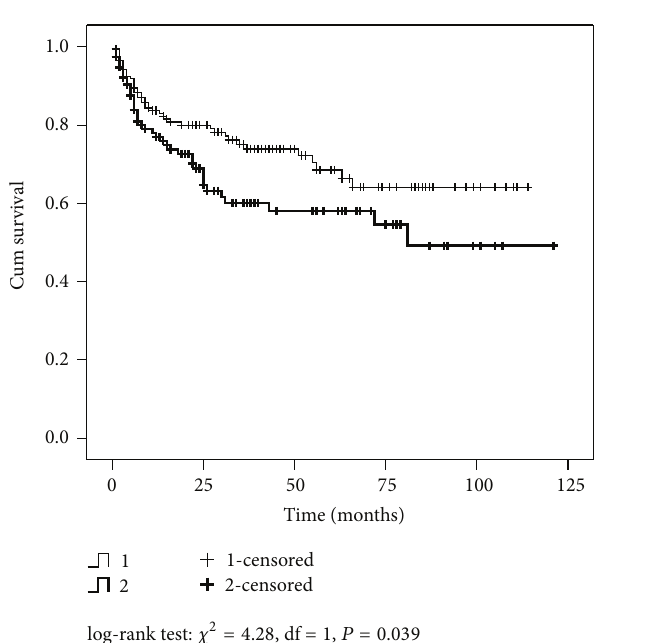
Figure1:Disease-freesurvivalbyGleasonscorebetweenbiopsyand radical prostatectomy (1: concordant; 2: upgrade).